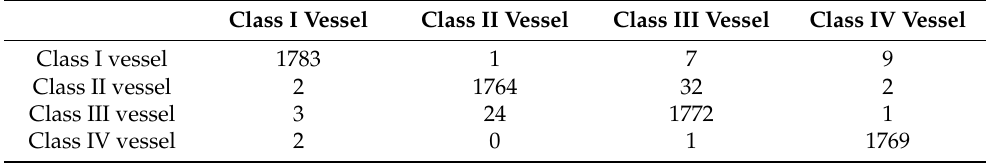
Table 5. Confusion matrix of